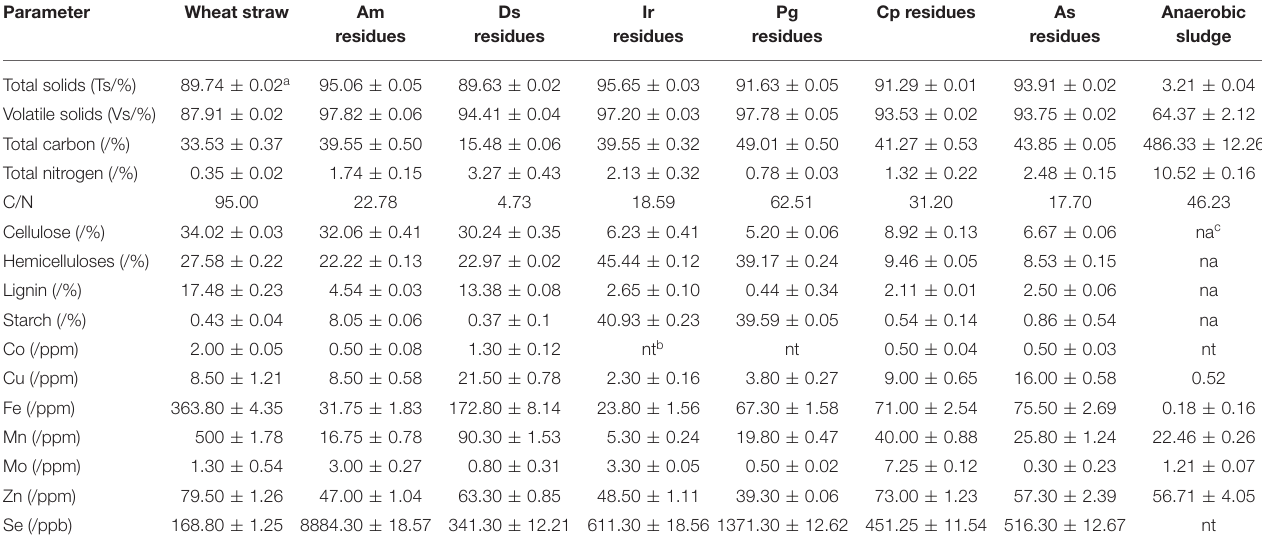
TABLE 1 | Characteristics of wheat straw, HPR, and anaerobic